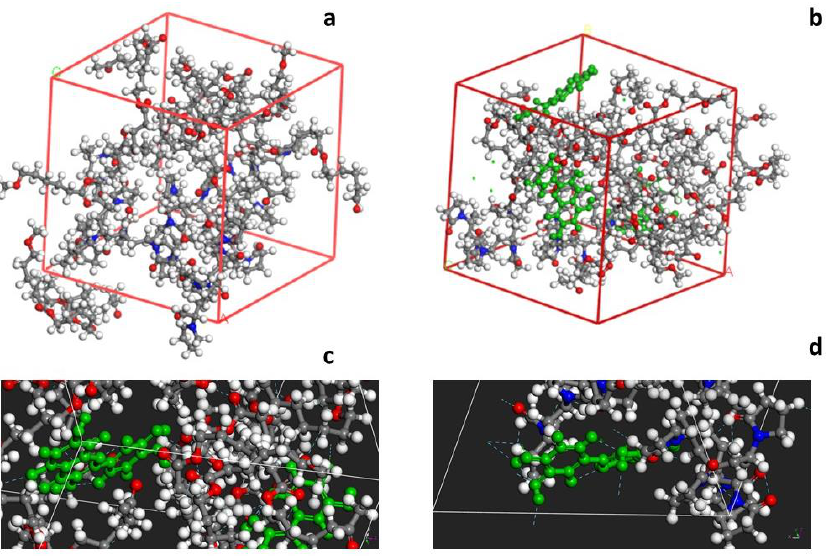
Figure 4. The amorphous unit cell of PCL/PVP ( a ) and PCL/PVP + Querc ( b ); H bond interactions between PCL and quercetin ( c ), and PVP and quercetin ( d ).